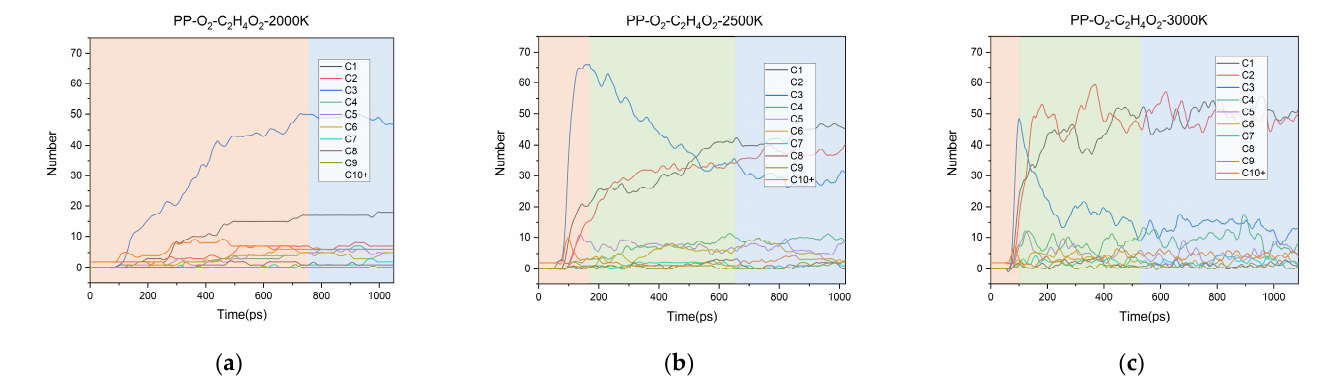
Figure 4. Distribution of major products at: ( a ) 2000 K; ( b ) 2500 K; ( c ) 3000